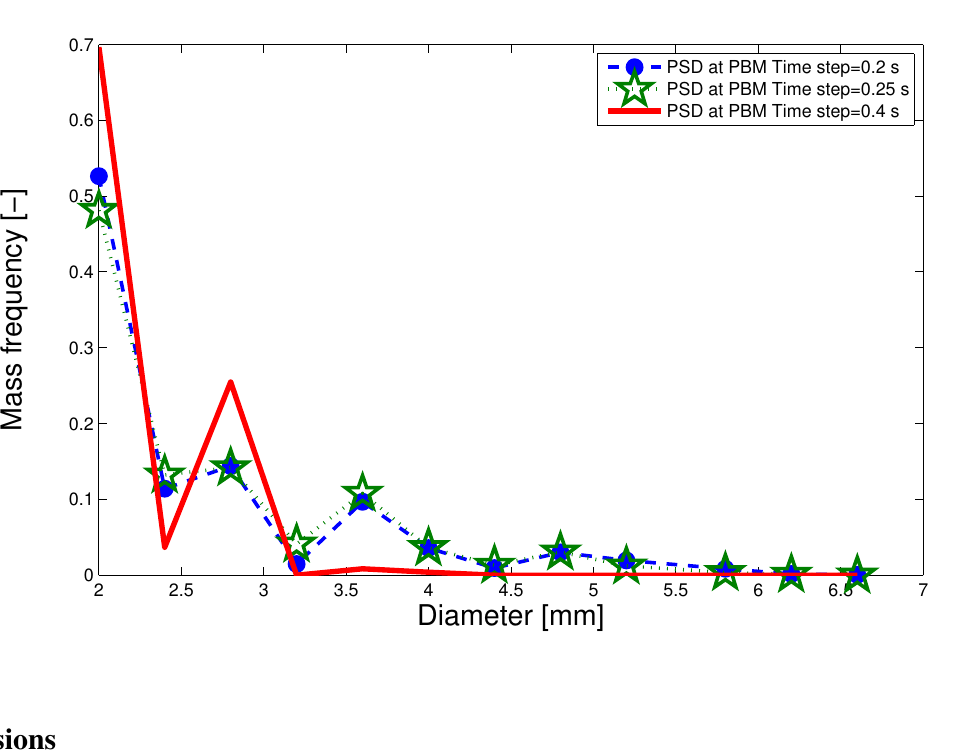
Figure 10. PSDs for different PBM time